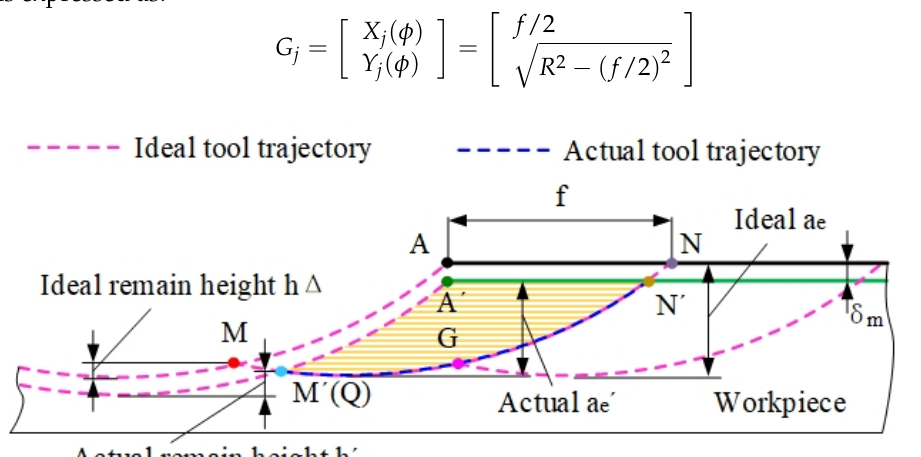
Figure 7. Surface topography formation area [38].